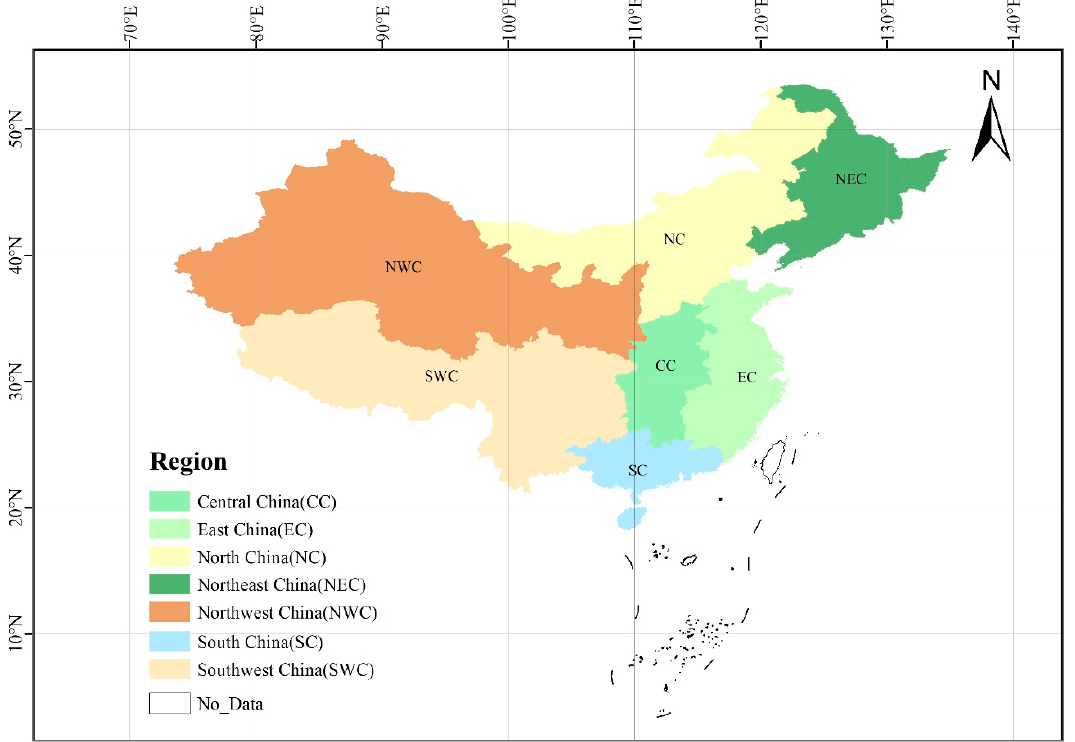
Figure 1. The study area of seven regions in China.